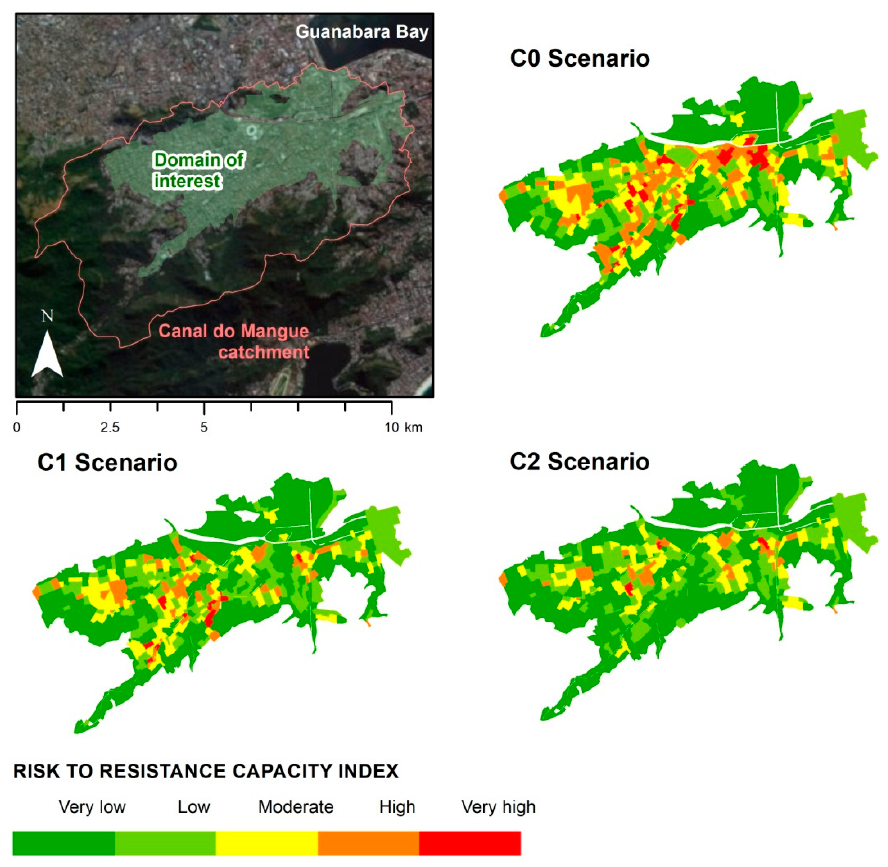
Figure 11. Risk to Resistance Capacity Index (RCI) for a 25-year event: (C0) without interventions, (C1) concentrated measures and (C2) distributed interventions.